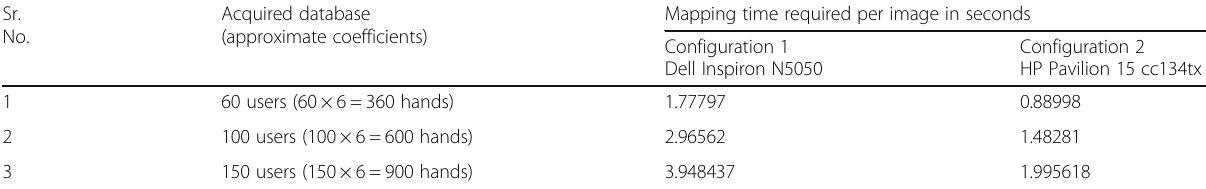
Table 6 Mapping time required using only approximate coefficients Sr. No.